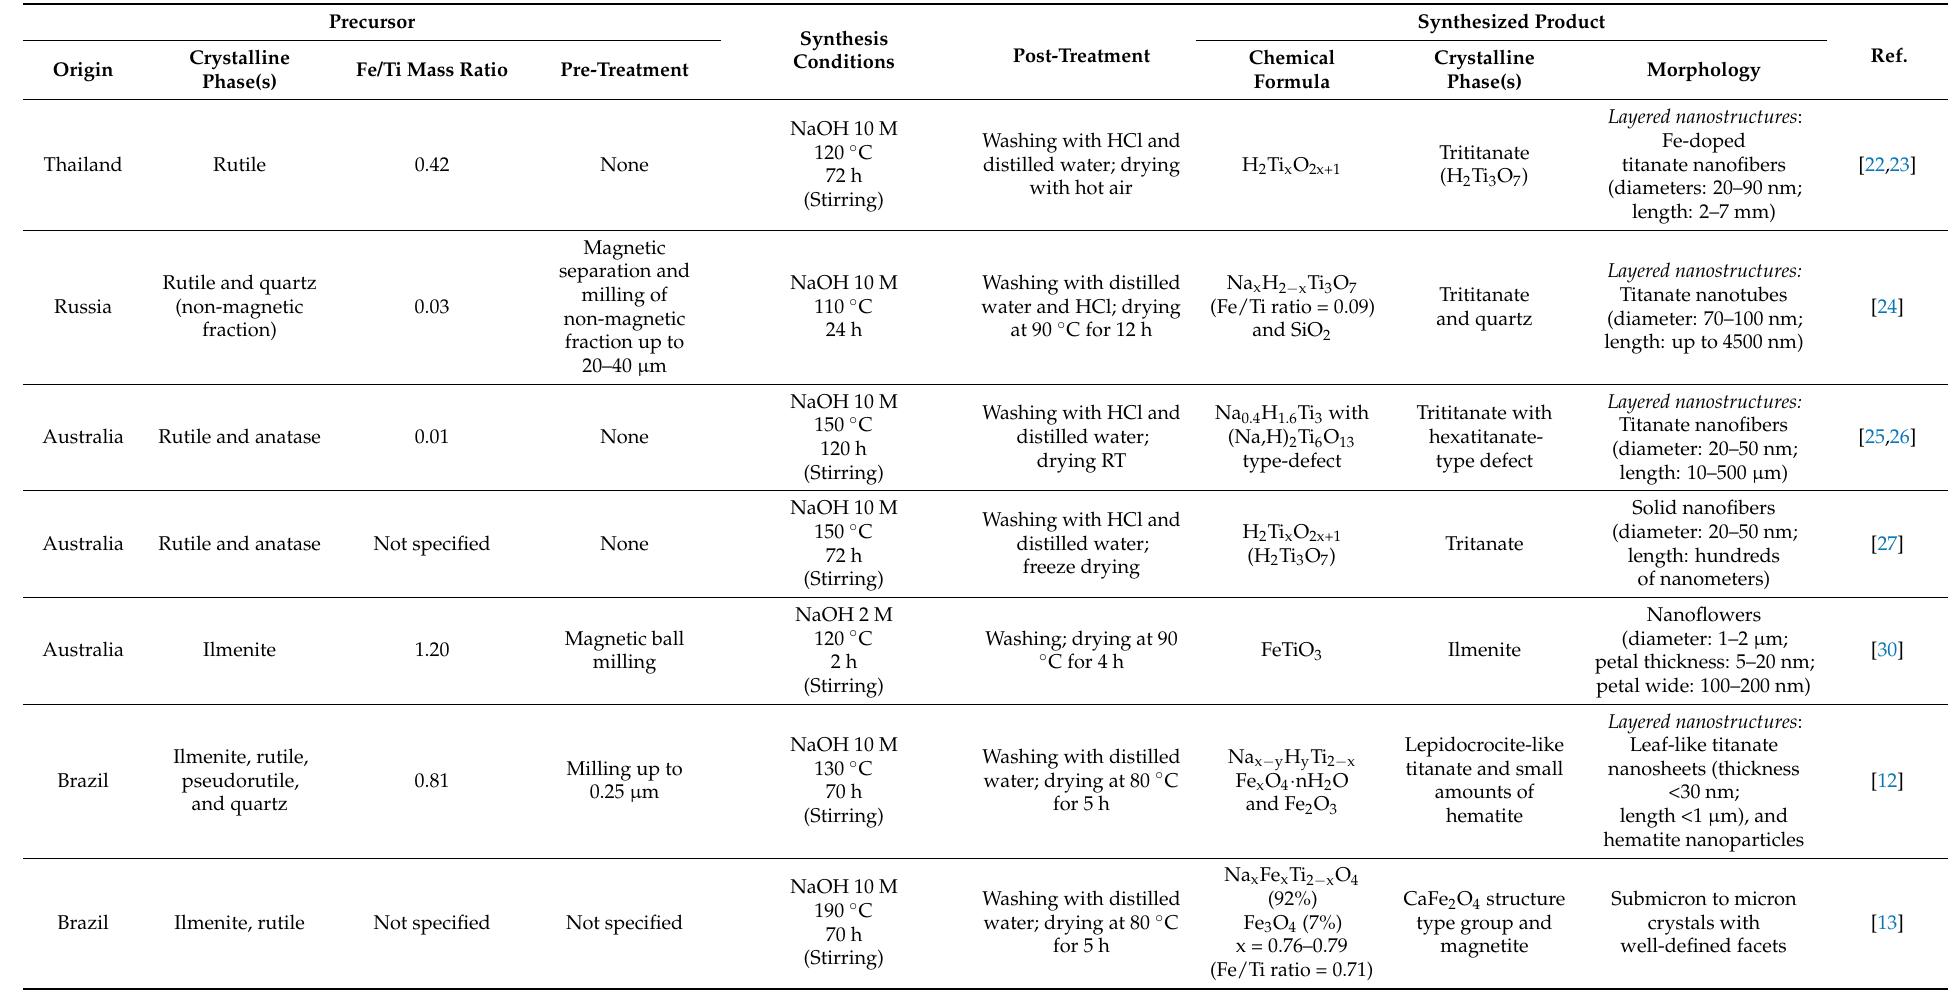
Table 1. Preparation of Fe-Ti-NS: precursors, synthesis conditions and